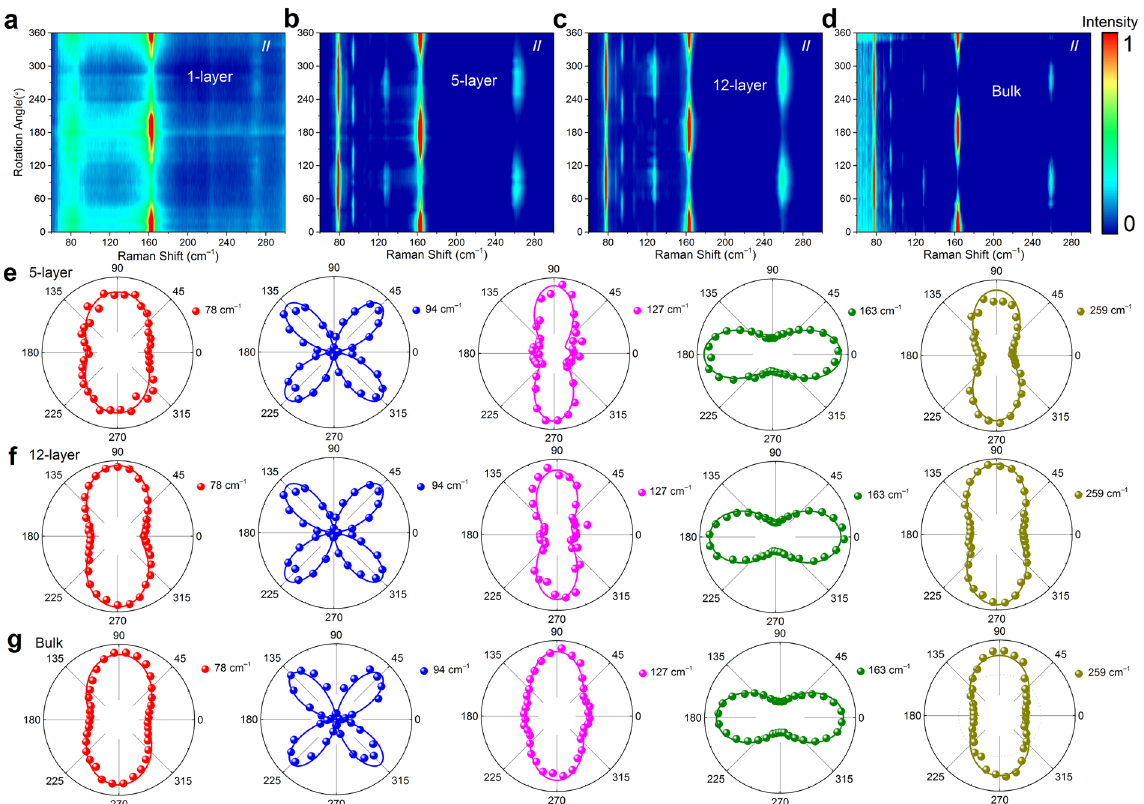
Figure 2. The sample rotation angle dependent Raman spectra of ( a ) 1-layer, ( b ) 5-layer, ( c ) 12-layer and ( d ) bulk 1 T´-MoTe 2 in the parallel polarization configuration. The polar plots of the angle-dependent intensities of phonon modes in ( e ) 5-layer, ( f ) 12-layer and ( g ) bulk 1 T´-MoTe 2 . The initial angle is set when the crystalline a -axis is parallel to the incident